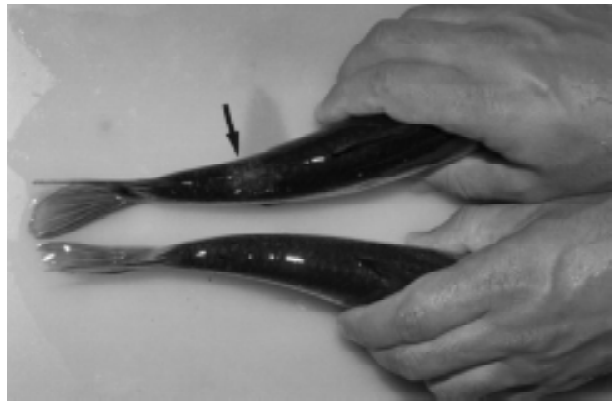
Figure 3 - Comparison between a biopsied animal (above) and non-biopsied one (below) after